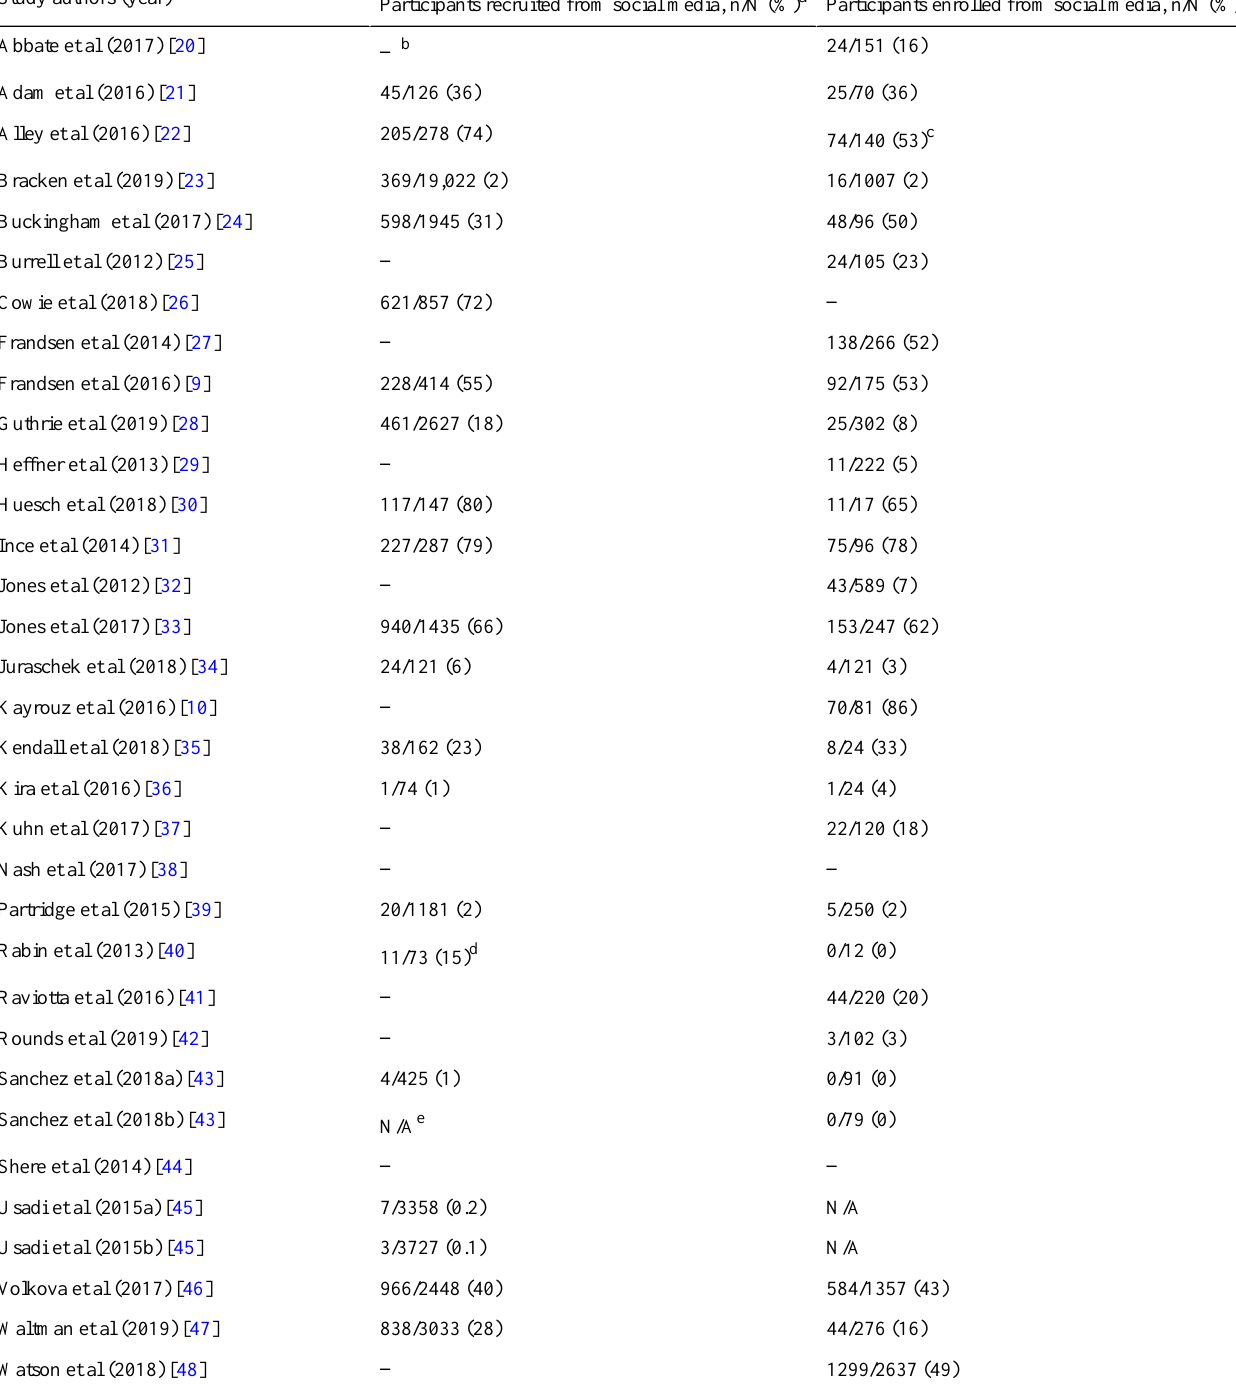
Table 2. Reported recruitment and enrollment from social